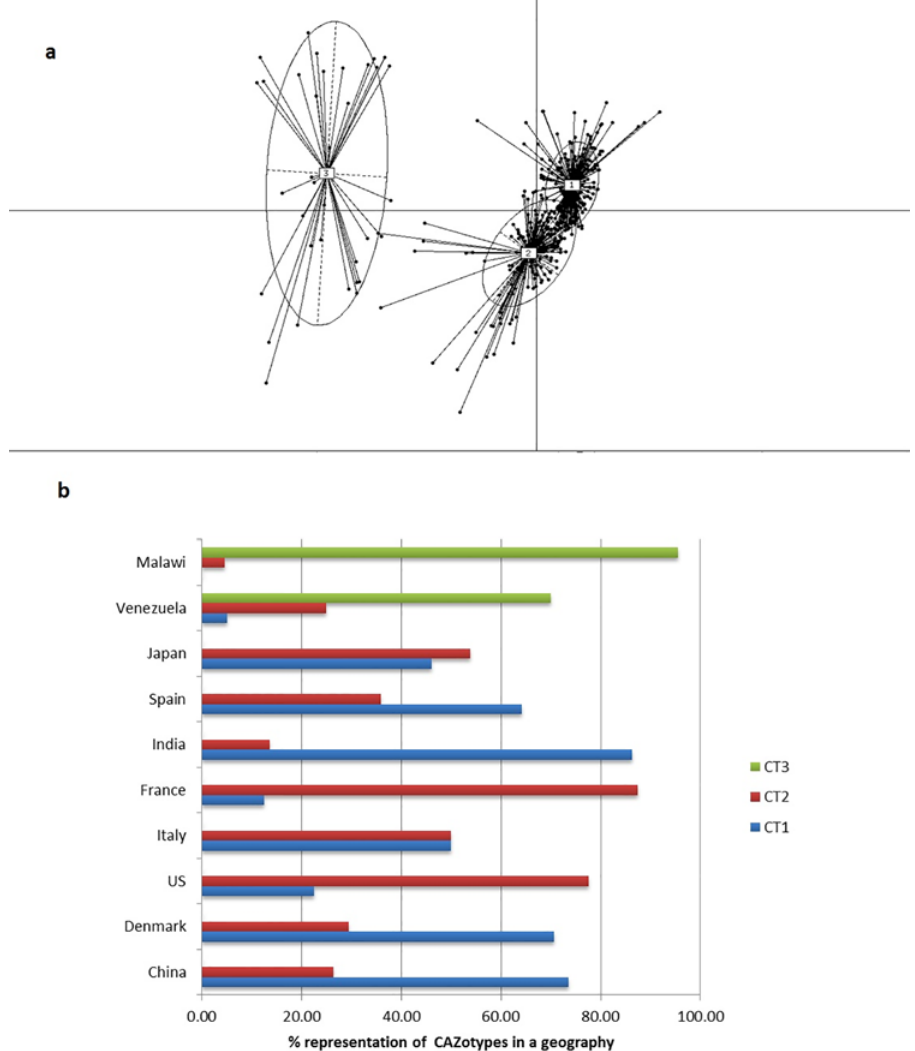
Fig 6. Identification of CAZotypes. (a) Distinct clustering of gut microbiomes based on similarities in the CAZyme profiles obtained using the BCA analysis. Each cluster represents a ‘ CAZotype ’ . (b) CAZotype distributions across various nationalities. The CAZyme profiles of the 448 gut microbiomes could be grouped into three distinct clusters, referred to as CAZotypes. Further, the gut microbiomes from individuals of various geographies, were observed to have differential preferences to belong to one of the three